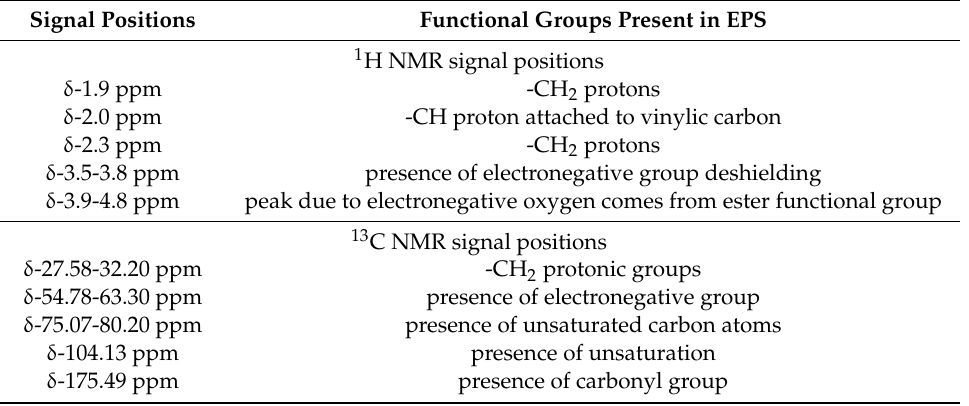
Table 1. Characteristic 1 H NMR and 13 C NMR signal positions with corresponding functional groups of the extracellular polymeric substance (EPS) produced by Bacillus licheniformis strain KX657843 isolated from earthworm ( Metaphire posthuma )